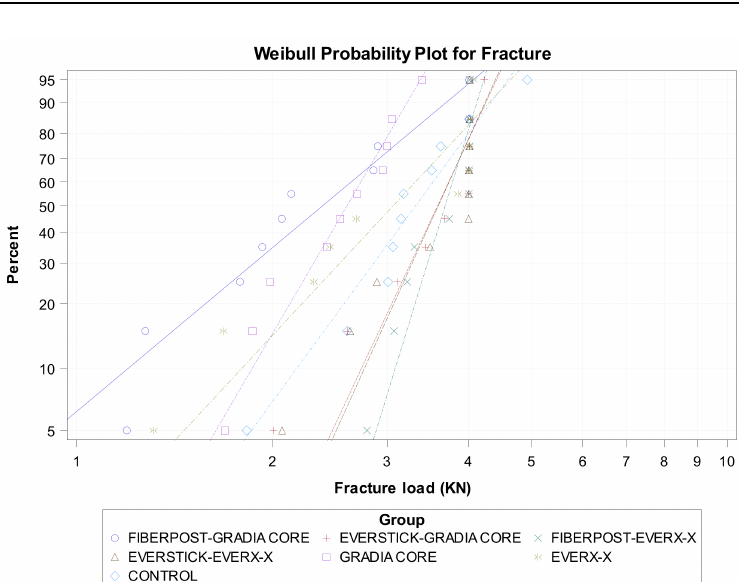
Figure 7. Weibull probability plot of the fracture resistance values (N) of the study groups after bending